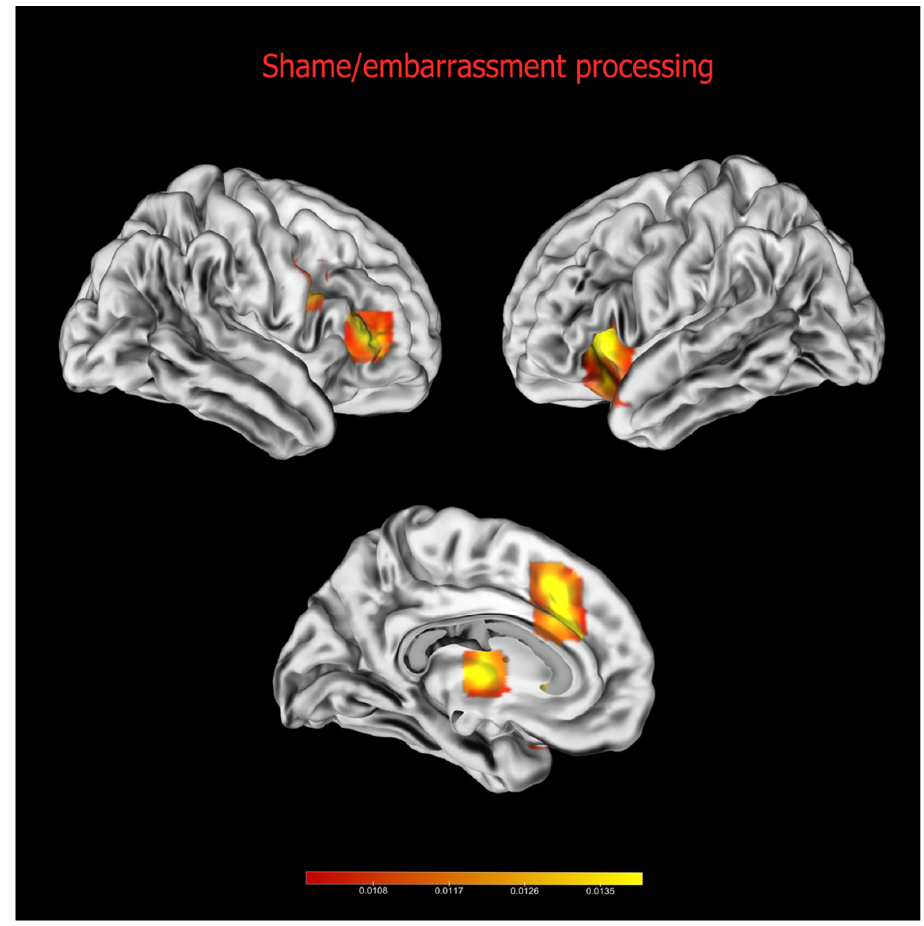
Figure 1. Results of the meta-analysis on shame/embarrassment neural correlates. Bars represent ALE scores. ALE